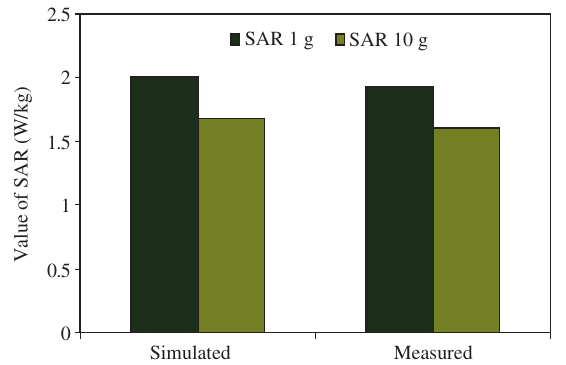
Figure 5 Comparison of SAR values between simulation and meas- urement results without the SMM attachment.